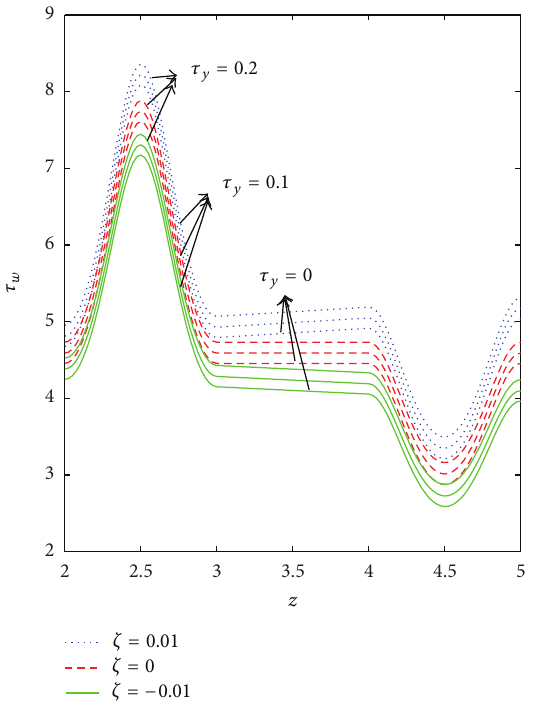
Figure 9: Variation of flow resistance ( 𝜆 ) for various fluids with respect to axial distance taking 𝛿 = 0.2